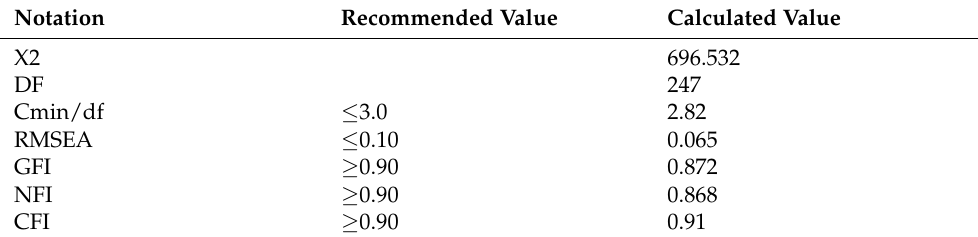
Table 5. Results of testing the model fit of the final structural